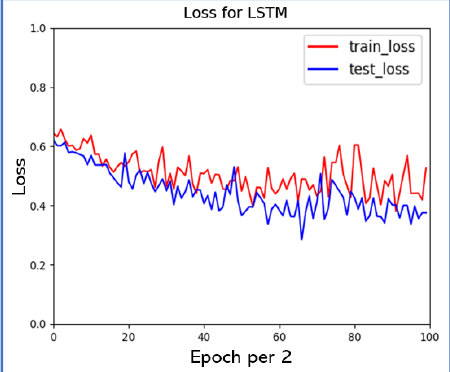
Figure 7. Train loss by LSTM algorithm.